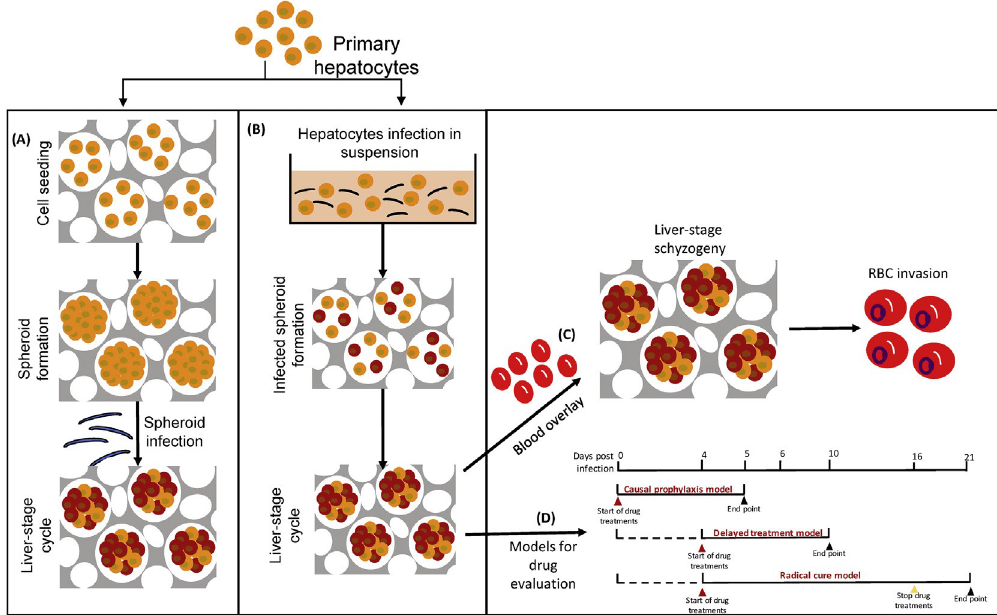
Fig 2. In vitro hepatic spheroid formation. Schematic diagram showing hepatic spheroid formation in the 3D Cellulosponge in vitro system for P . cynomolgi parasites. (A) Spheroids of uninfected hepatocytes. (B) Spheroids of hepatocytes pre-infected using sporozoites. (C) Successful reinfection and completion of life cycle in erythrocytes. (D) Potential models for drug evaluation in liver stages are shown. Open-access image reused from [52]. R AU : AbbreviationlistshavebeencompiledforthoseusedthroughoutFigs 2 and 3 : Pleaseverifythatallentriesarecorrect : BC, red blood cell.